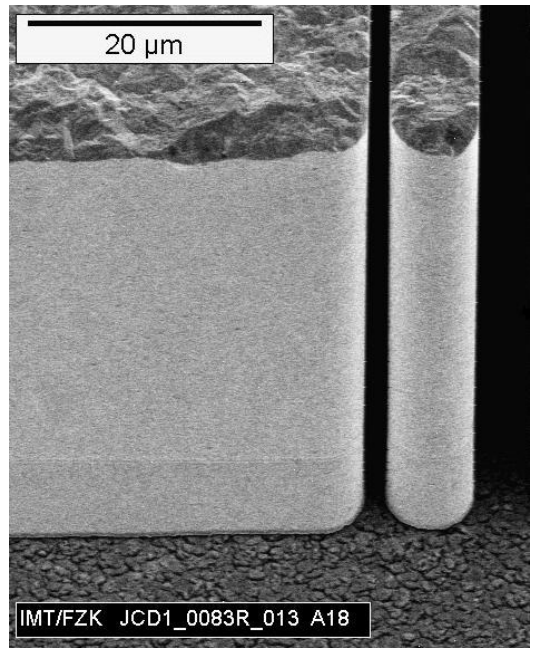
Figure 4. Tip of RF MEMS cantilever beam fabricated in nickel using the LIGA process showing narrow (1.8 μm) high aspect ratio (55:1) gap. Bottom text denotes sample fabrication at IMT in Karlsruhe,